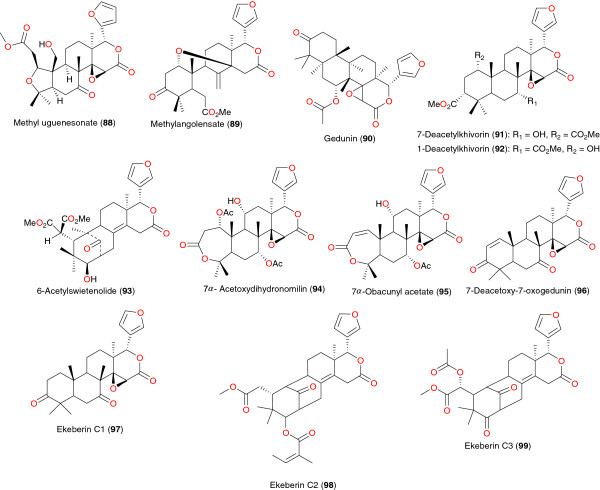
Limonoids from African medicinal plants with antiplasmodial activity.